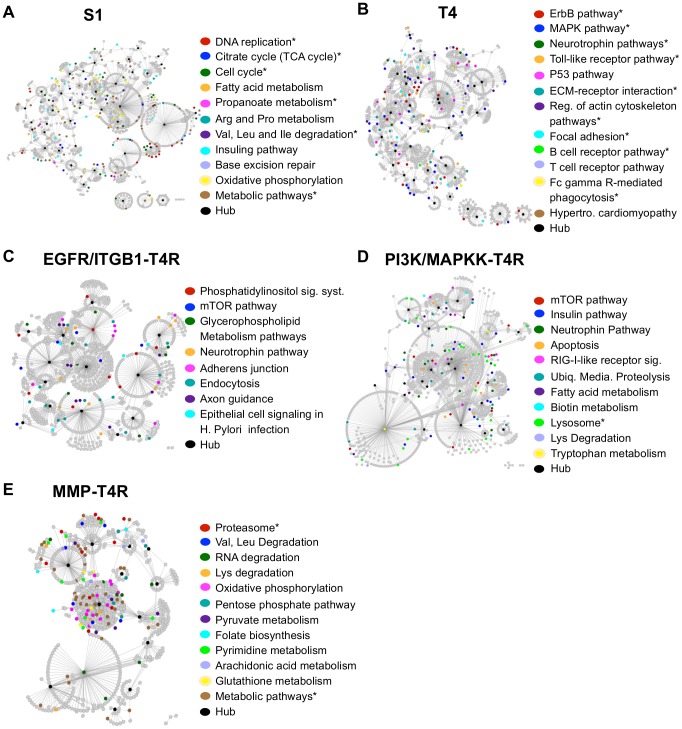
Illustration of selected enriched pathways in the differential network of each breast cell state.(A) S1; (B) T4; (C) the EGFR/ITGB1-T4R group; (D) the PI3K/MAPKK-T4R group; and (E) the MMP-T4R group. In each plot, the differential network for the corresponding cell state is shown. Nodes represent genes; edges represent interaction of the genes. Selected pathways enriched in the network (unadjusted p-values<0.05) are color-coded and shown on the right; genes participating in the selected pathways are also colored based on the color code for the corresponding pathway. An asterisk indicates a pathway that is significantly enriched in the corresponding differential network. The pathway names are shortened to save space. See Table S1 for detailed information about the enriched pathways in each cell state.